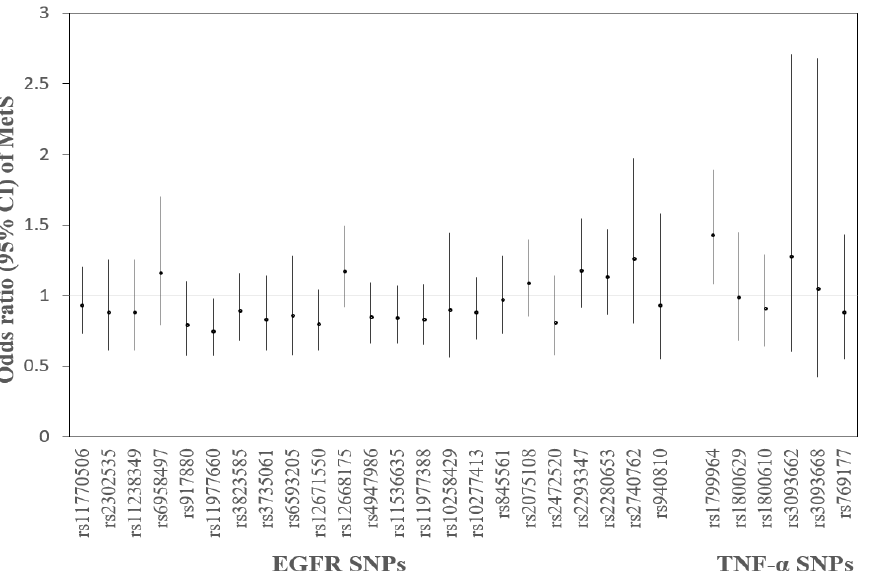
Figure 2. Odds ratios (ORs) and 95% confidence intervals (CIs) of metabolic syndrome (MetS) with 29 SNPs, respectively. Adjusted for age, gender, smoking, and drinking alcohol. (rs1799964, rs1800629, rs1800610, rs3093662, rs3093668, and rs769177 are TNF- α SNPs, and the others are EGFR SNPs.).